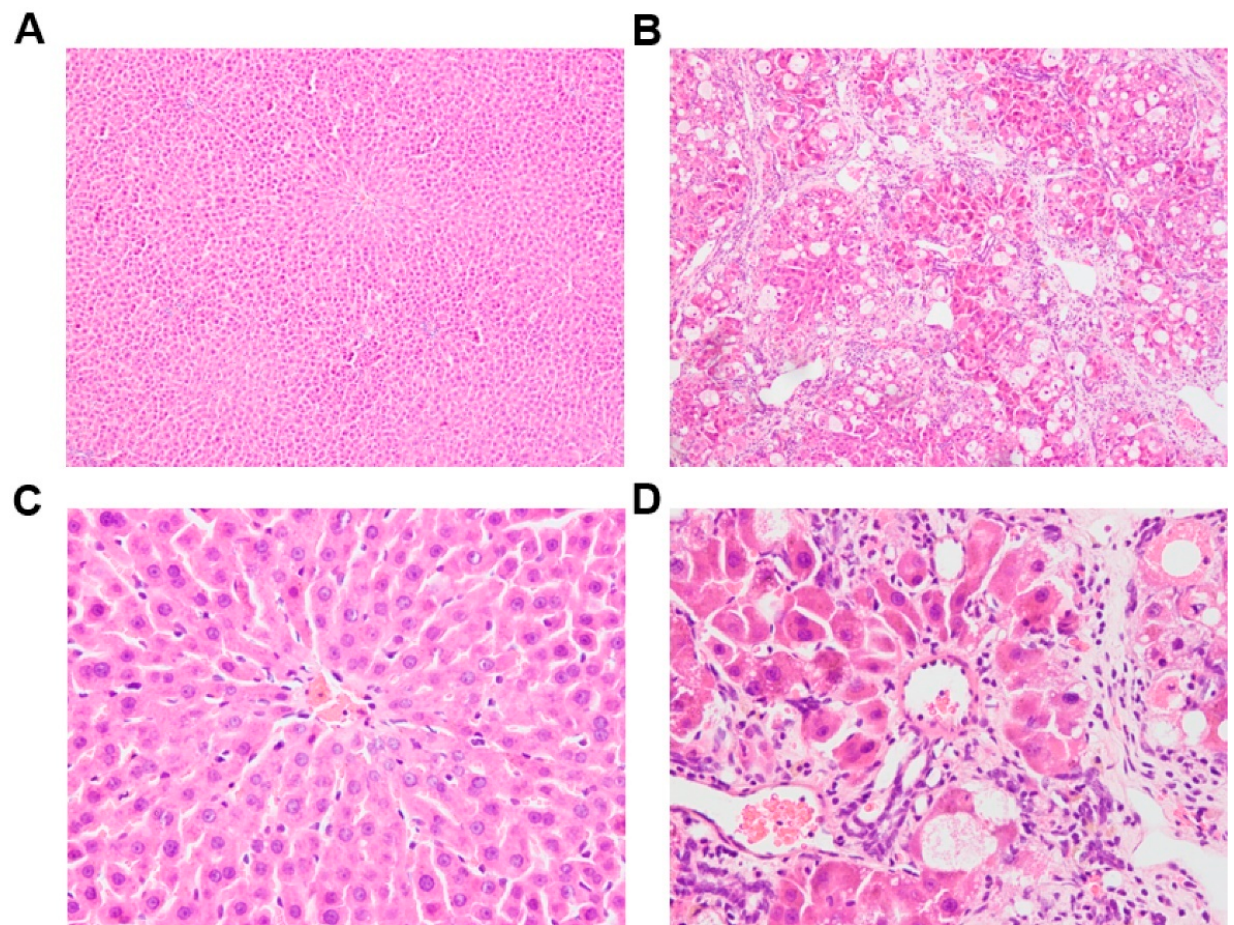
Figure 2. Histology of liver tissue from control (( A ): 100 ×, ( C ): 400 ×) and CCl 4 -induced (( B ): 100 ×, ( D ): 400 ×) rats using hematoxylin–eosin staining.